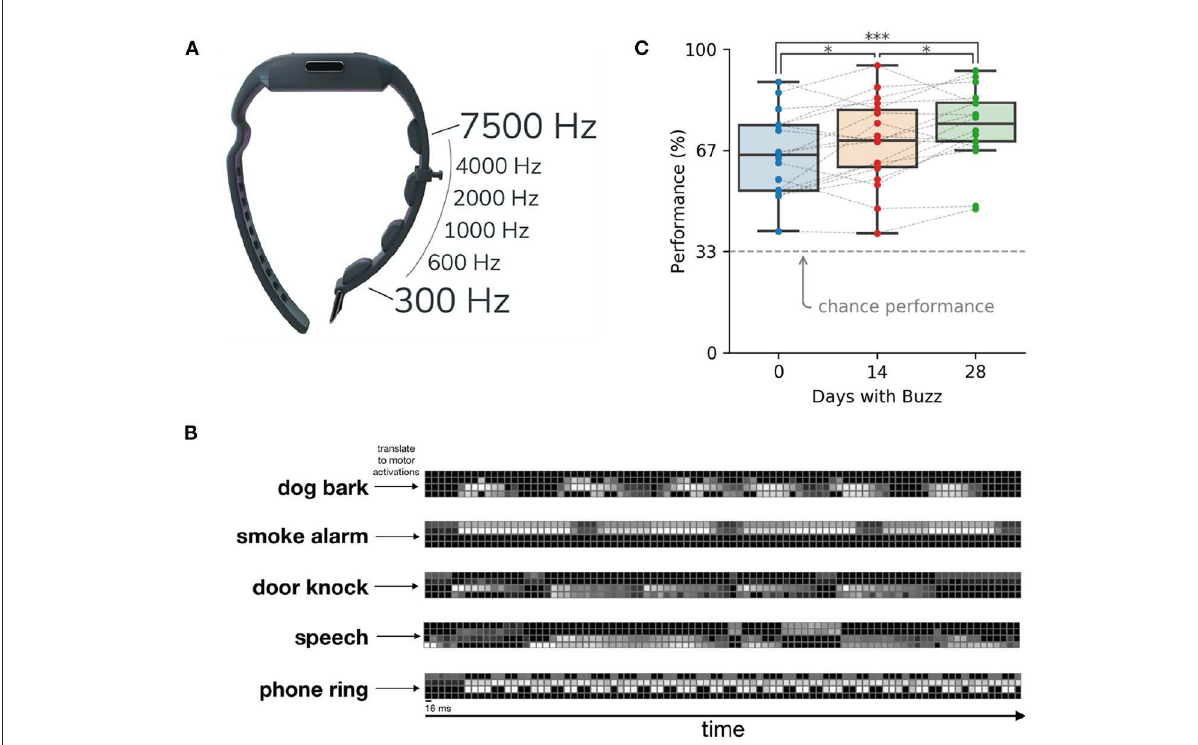
FIGURE1 A sensory substitution wristband for deafness (the Neosensory Buzz). (A) Four vibratory motors in a wristband transfer information about sound levels in different frequency bands. (B) Sample sounds translated into patterns of vibration on the motors of the wristband. Brighter colors represent higher intensity of the motor. (C) Participant performance on sound identification improves through time. Data reprinted from Perrotta et al.